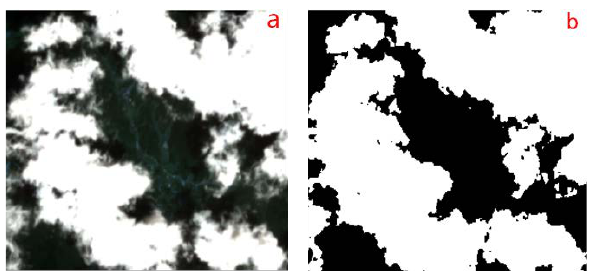
Figure 4. Example of BOTF cloud mask. (a)RGB composite image (Scene ID: E119.1_N25.6_20160830). (b) BOTF cloud mask.